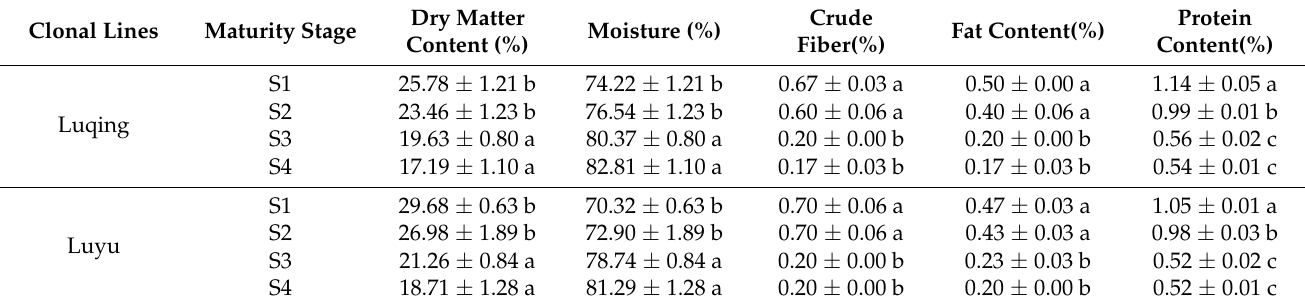
Table 2. Proximate composition of Akebia trifoliata fruit at four maturity stages (mean ± standard error). Clonal